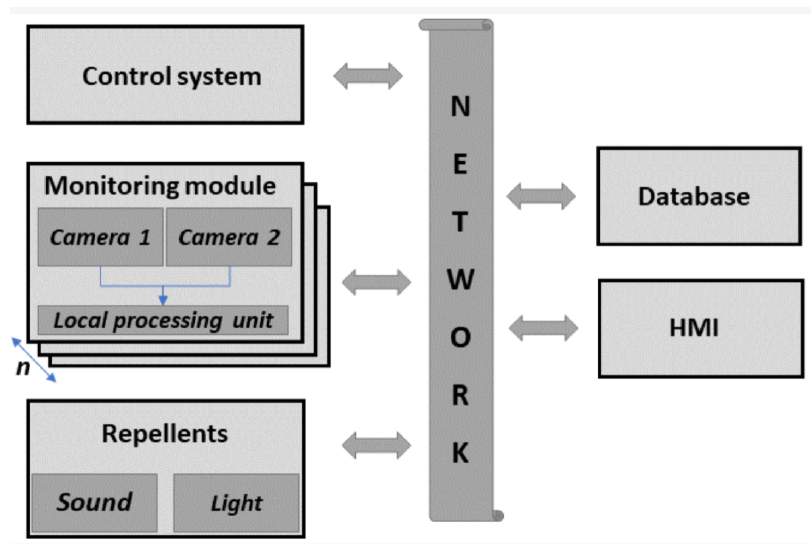
Figure 1. Data collection system block diagram